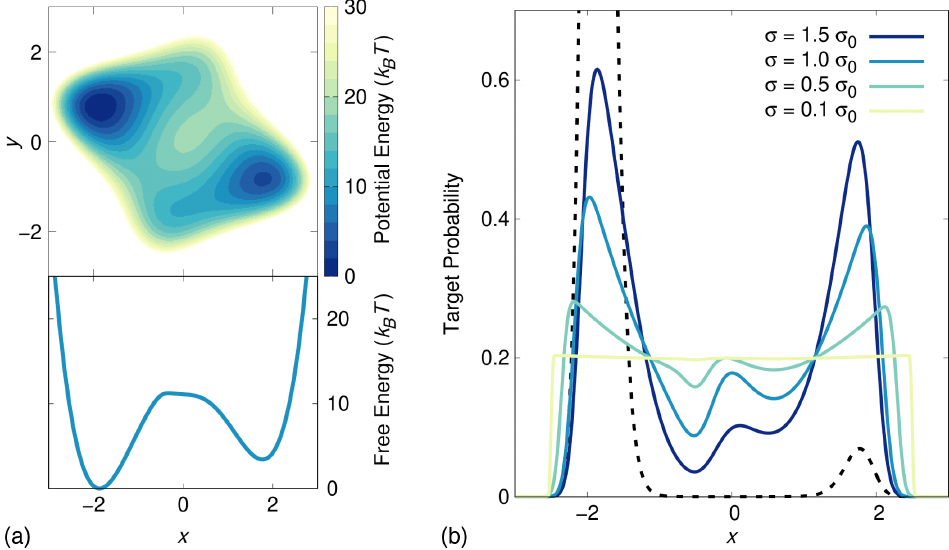
FIG. 5. Double-well model in the multiumbrella ensemble. (a) Potential energy of the double-well 2D model system, and its free energy along the x coordinate. (b) Multiumbrella target distribution, for different values of umbrella width σ . The black dotted line is the unbiased probability distribution P 0 ð x Þ